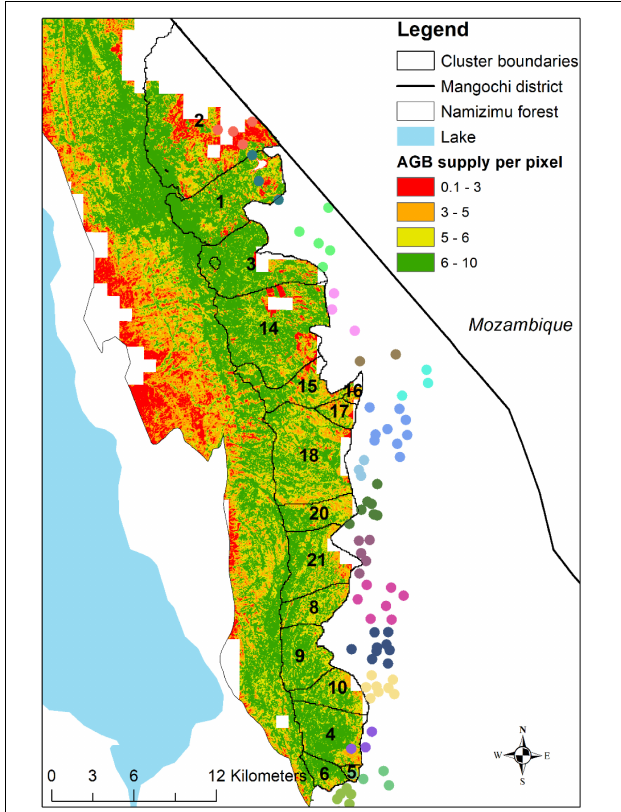
FIGURE 2 | In the figure, we show the results of the potential supply quantification, i.e., the potential biomass that can be extracted from Namizimu forest reserve. The map presents the AGB estimated for each pixel of 30 m × 30 m size (0.09 ha) and therefore the order of magnitude of the estimates differs from the standard measure of biomass expressed in t/ha. The biomass map is overlaid with the boundaries of the modelled co-management blocks. These blocks together form the forest catchment area corresponding to the cluster of villages located on the east side of the forest. Villages of the same colour belong to the same cluster and are allocated one specific co-management block in the